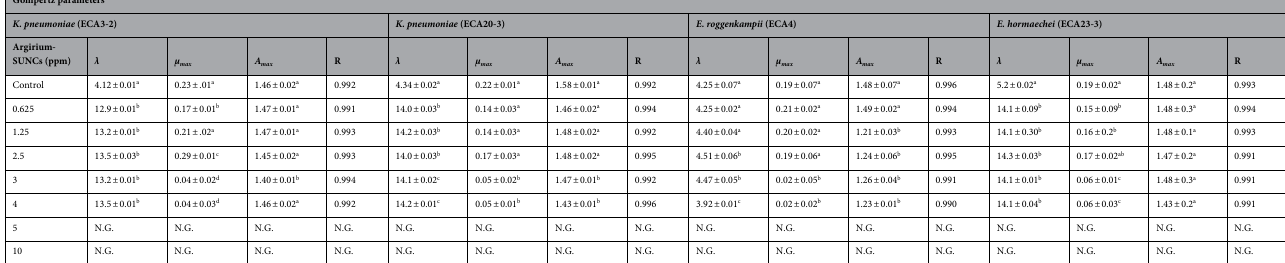
Table 2. Influence of Arg-SUNCs concentration, on the growth parameters of K. pneumoniae (ECA3- 2), (ECA20-3) E. roggenkampii (ECA 4) and E. hormaechei (ECA23-3) in TSB Medium, calculated using modified Gompertz Equation. Mean and standard deviation of five repetitions. Different lowercase letters (a, b, c) indicate significant differences (p ≤ 0.05). A max maximum absorbance (expressed as DO units) during stationary phase, μmax maximum growth rate (1/h), λ lag phase (h), N.G . not